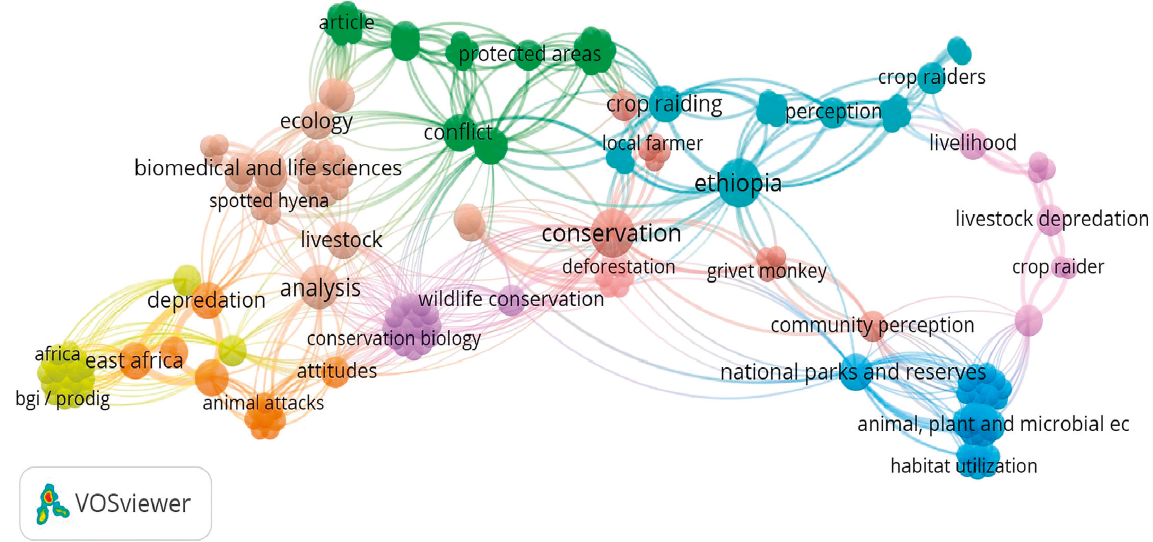
Figure 7: Network of keywords co-occurrence for HWC research in